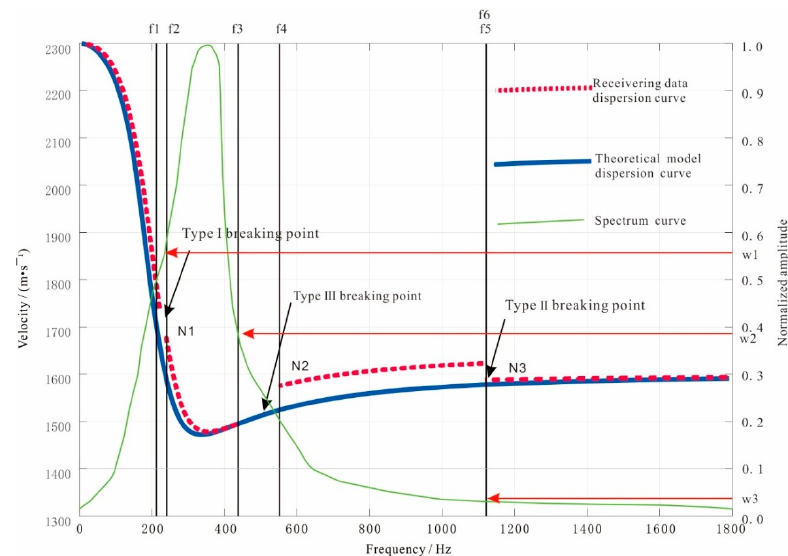
Figure 2. Dispersion curve breaking point classification and weighting factors.